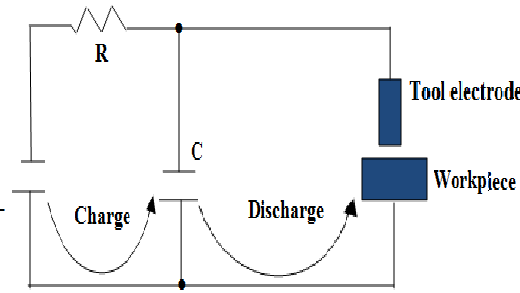
Figure 1: Schematic diagram of relaxation type pulse generator in EDM [12]